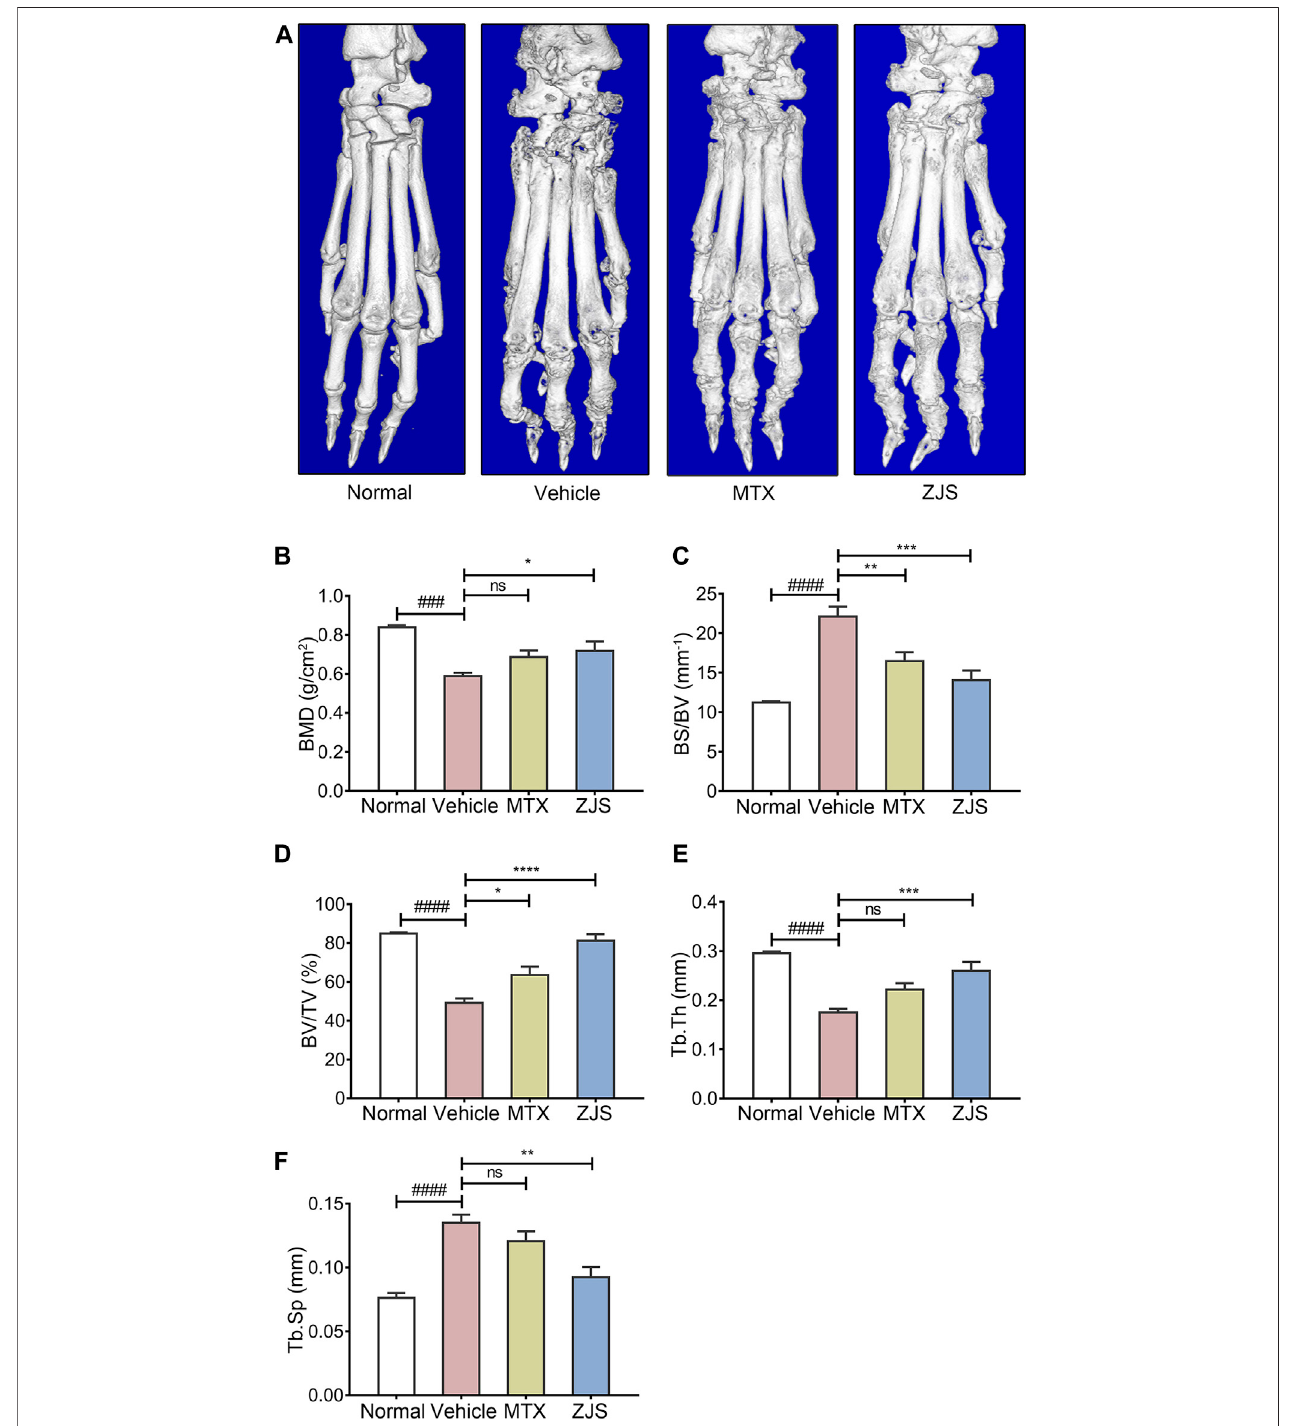
FIGURE3| ZJSsuppressedjointboneerosioninCIAmice. (A) Representativethree-dimensionalrenditionsofhindpawsfrommiceintheindicatedgroups,which wereobtainedusingmicro-CT. (B) Bonemineraldensity (BMD)oftheanklejointsintheindicatedgroups( n (cid:1) 5). (C) Theratioofbonesurfacetobone volume(BS/BV)of the ankle joints in the indicated groups ( n (cid:1) 5). (D) Bone volume fraction (BV/TV) of the ankle joints in the indicated groups ( n (cid:1) 5). (E) The bone trabecular thickness (Tb.Th) of the ankle joints in the indicated groups ( n (cid:1) 5). (F) Bone trabecular separation (Tb.Sp) of the ankle joints in the indicated groups ( n (cid:1) 5). Values are presented as the mean ± SEM. ns: no signi fi cance. ### p < 0.005, #### p < 0.001, compared to the normal group. * p < 0.05, ** p < 0.01, *** p < 0.005, **** p < 0.001, compared with the vehicle group (One-way ANOVA test).